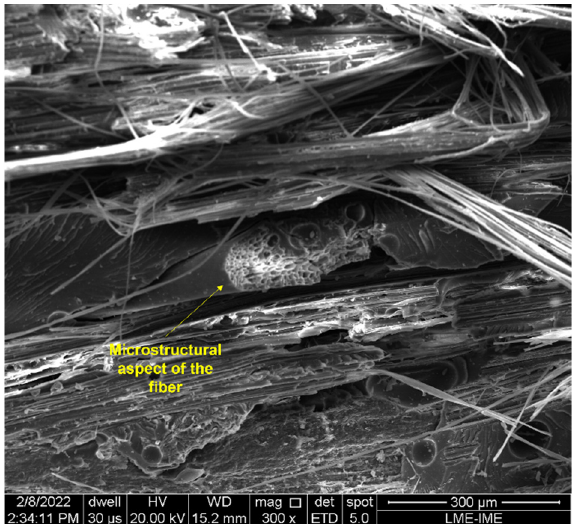
Figure 9. Fracture surface of a bidirectional composite with 30 vol.% fibers (PNT/EGO) at 300× magnification.